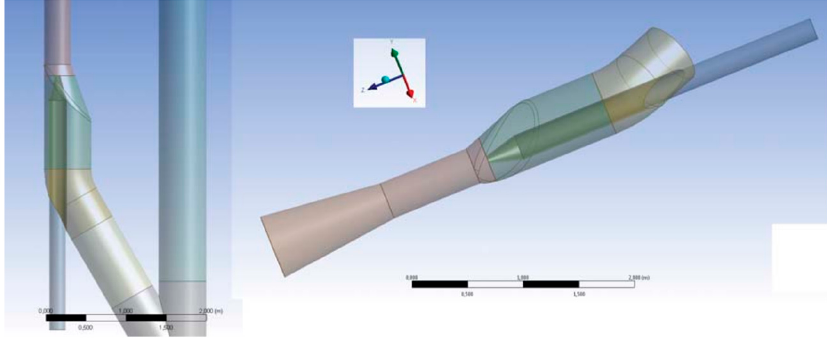
Figure 10. New eccentric jet